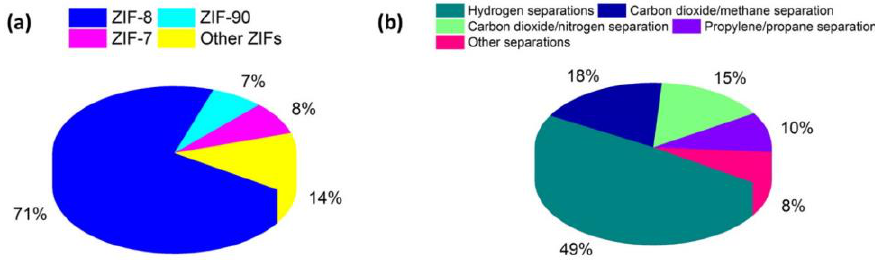
Figure 7. Publication information of ZIF membranes for gas separations. ( a ) ZIF materials and ( b ) application areas of ZIFs. Figure modified with permission of the authors of [125].